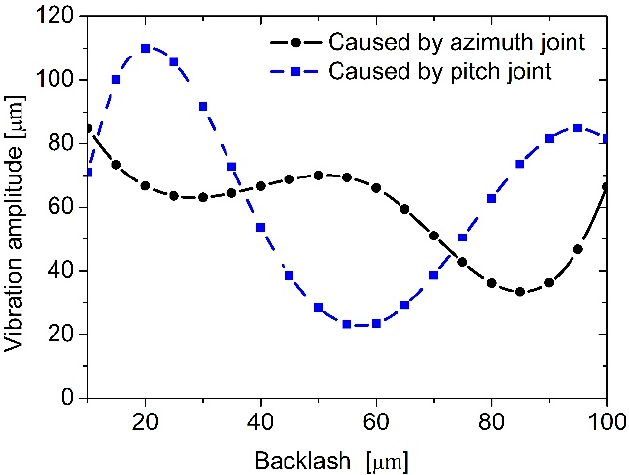
Figure 11. Vibration amplitude of antenna reflector with different backlashes—the solid line of dot-point represents the backlash in the azimuth joint; the dashed line of square-point represents the backlash in the pitch joint.